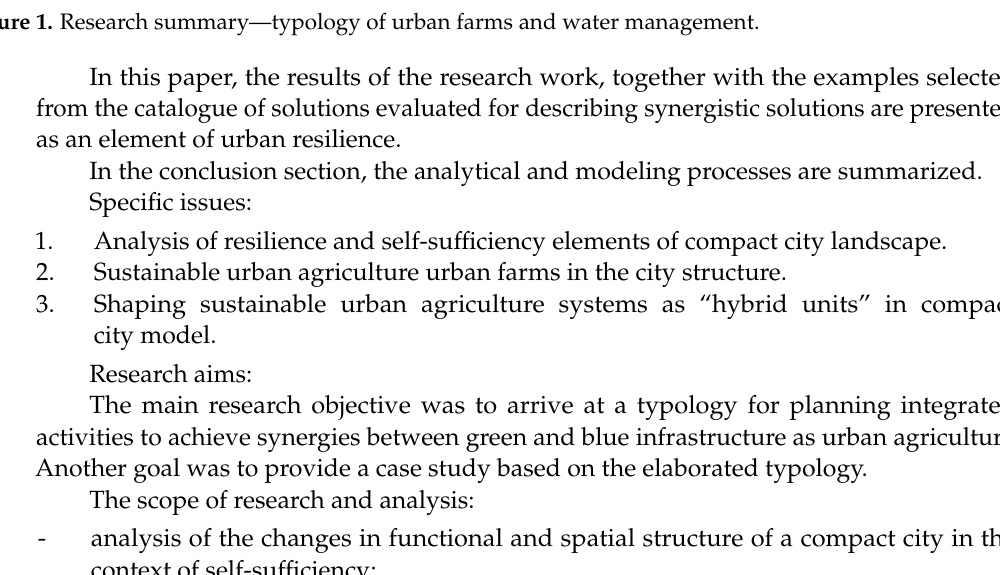
Figure 1. Research summary — typology of urban farms and water management.